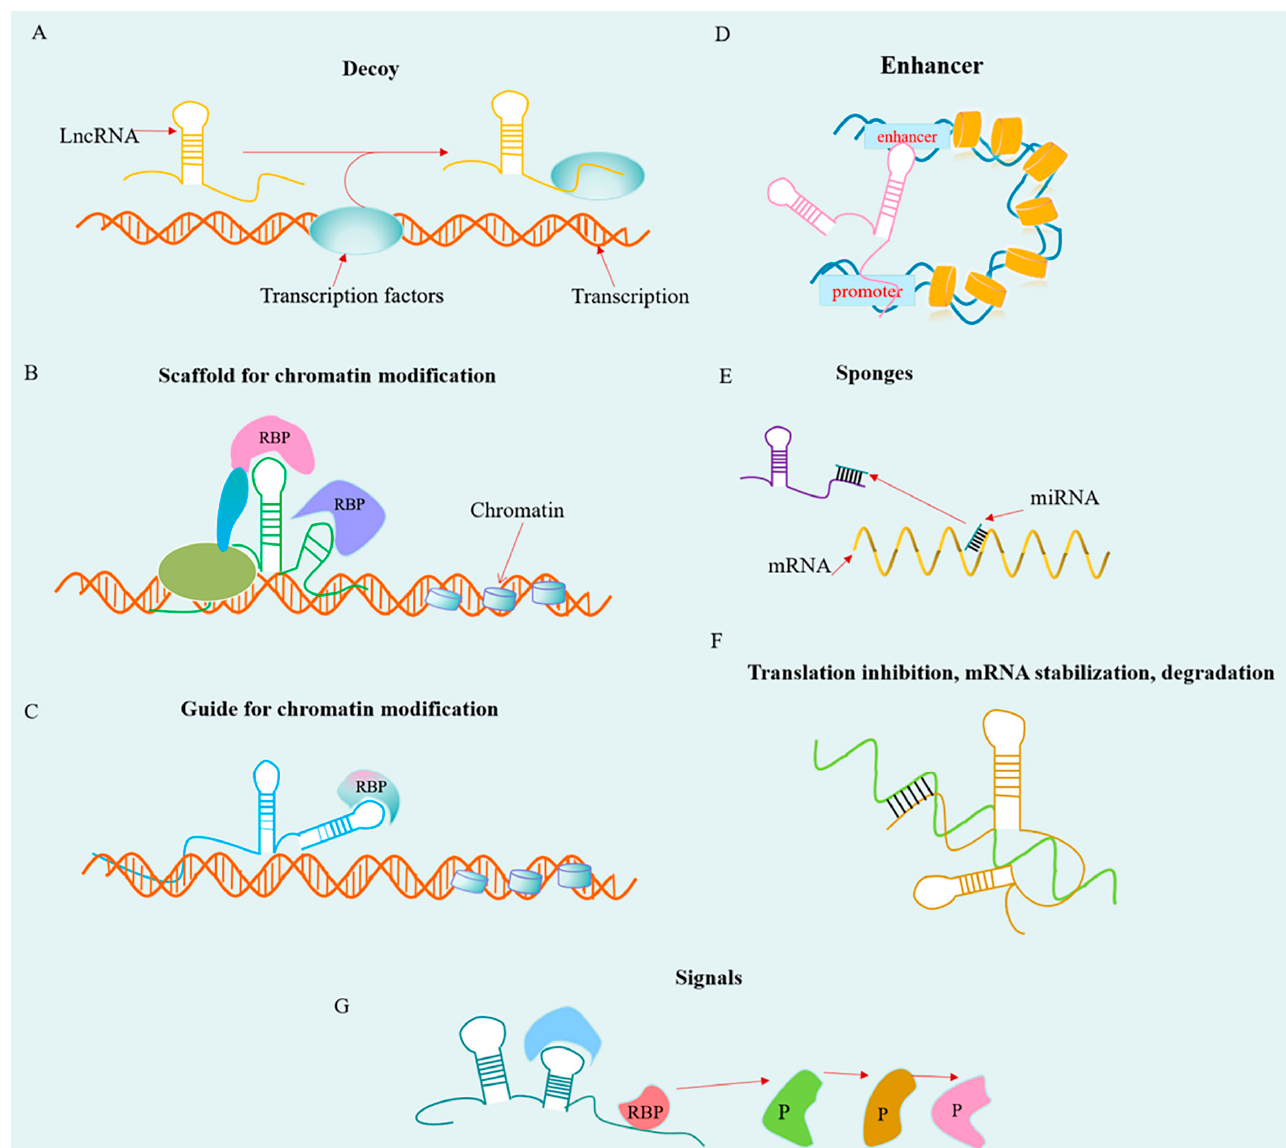
Figure 2. The molecular mechanisms of lncRNAs regulating cellular processes. ( A ) LncRNAs can act as decoys to facilitate transcription; ( B , C ) LncRNAs can seve as a scaffold or guide for chromatin modification; ( D ) LncRNAs promote R-loop formation to facilitate transcription; ( E ) LncRNAs can seve as ceRNAs by sponging to miRNA; ( F ) LncRNAs can regulate mRNA translation, stability, and degradation; ( G ) Signals—the RBP association with lncRNAs can contribute to conformational alterations that activate signal molecules.